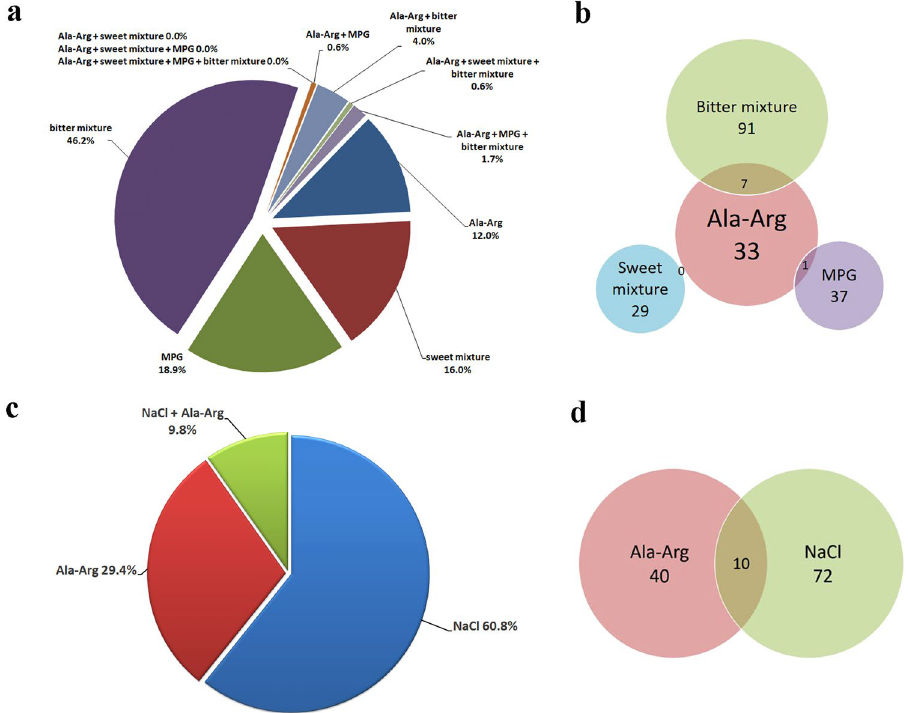
Figure 3. The breadth of tuning of Ala-Arg (AR) with sweet, bitter, umami, and salty taste. Sweet mixture (100 mM glucose and 1 mM sucralose), bitter mixture (2 mM phenylthiocarbamide, 2 mM denatonium benzoate, and 5 mM salicin), 5 mM monopotassium glutamate (MPG), and 150 mM NaCl were used as sweet, bitter, umami, and salt stimuli, respectively. (a) HBO cells were consecutively stimulated with four different stimuli: AR, sweet mixture, bitter mixture, and MPG. Of 576 HBO cells, 175 responded to at least one stimulus, as measured by Ca 2 + response. The experiment was performed eleven times. (b) Among 33 AR-responding cells, 1 and 7 cells responded to MPG and bitter mixture, respectively, but no AR-responding cells responded to the sweet mixture. (c) HBO cells were consecutively stimulated with NaCl (150 mM) and AR (50 µ M). The experiment was performed thirteen times. At least one stimulus elicited a Ca 2 + response in 102 of 679 HBO cells. (d) Among 40 AR-responding cells, 10 cells responded to